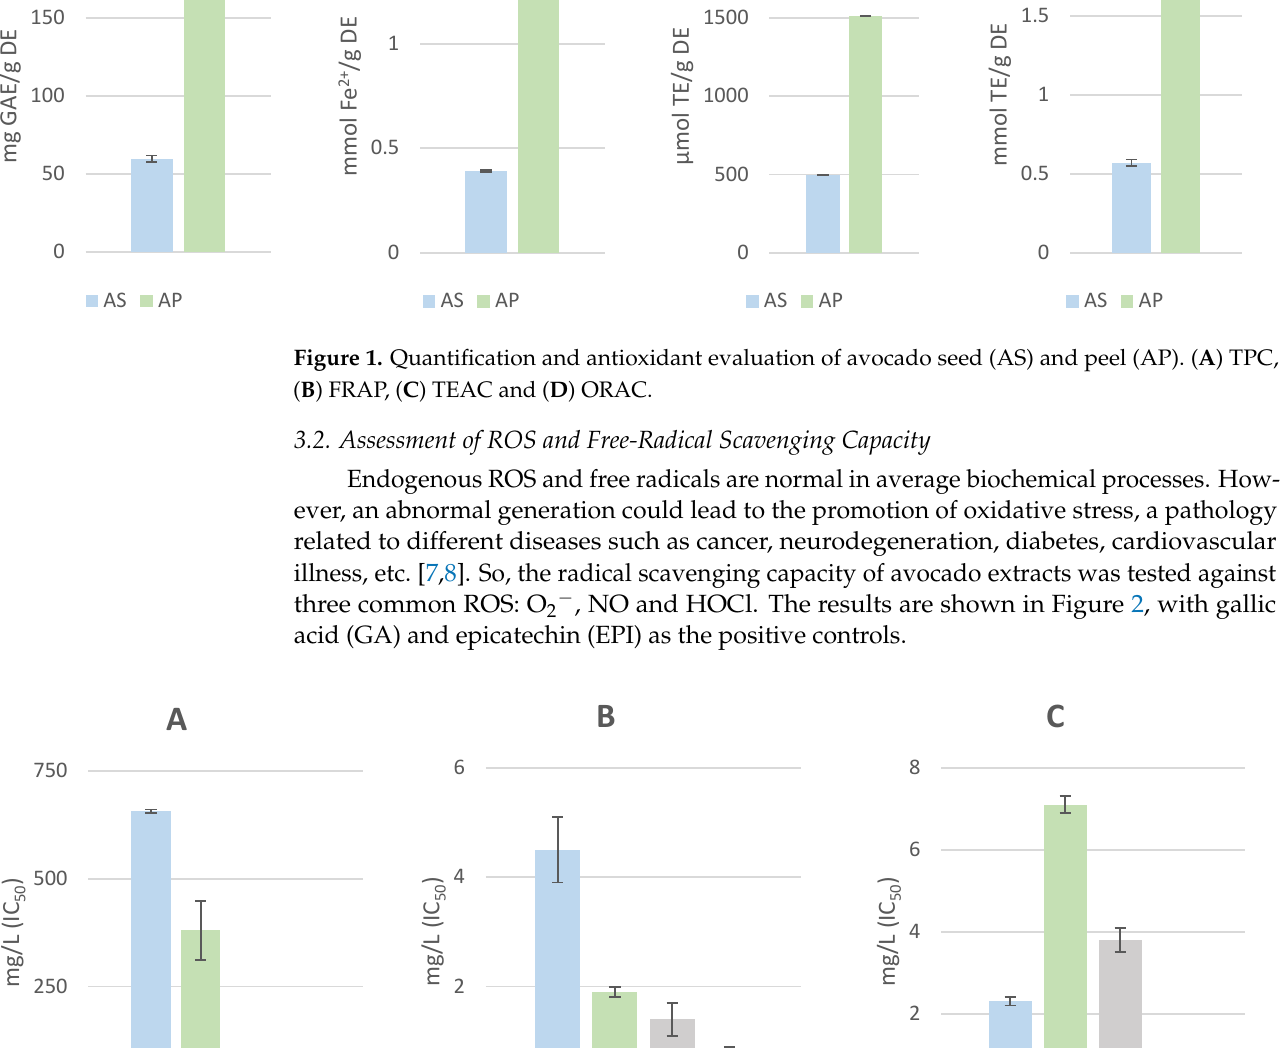
Figure 1. Quantification and antioxidant evaluation of avocado seed (AS) and peel (AP). ( A ) TPC, ( B ) FRAP, ( C ) TEAC and ( D ) ORAC.